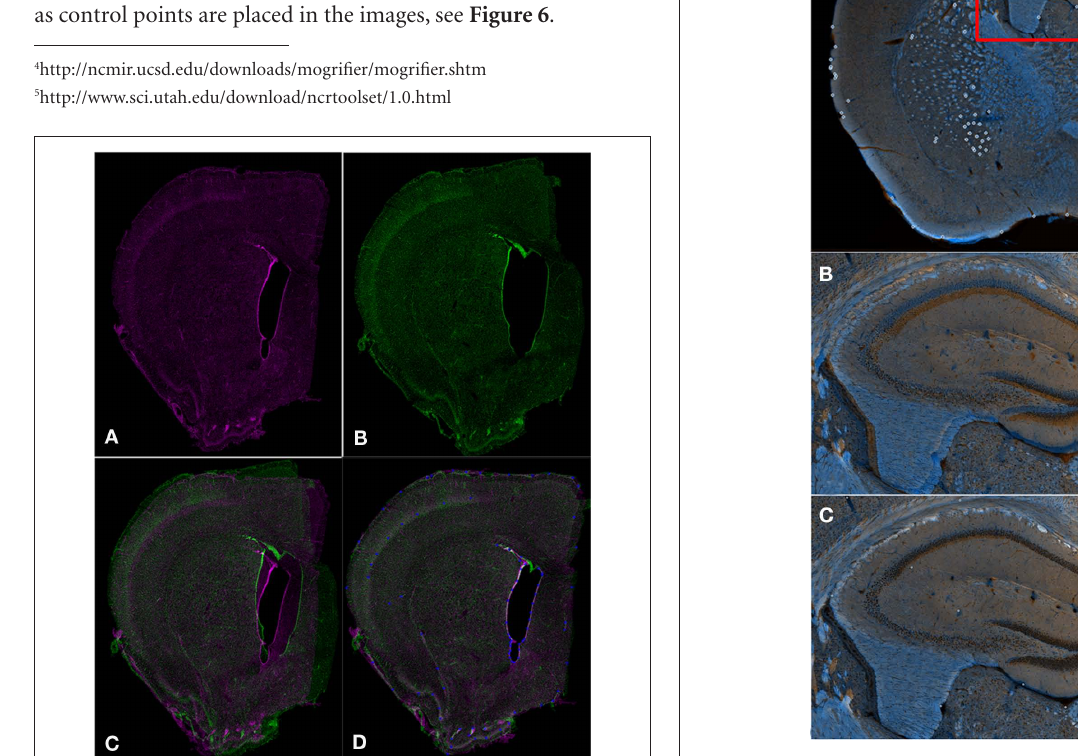
Figure 5 | Aligning serial sections using Mogrifier. Two serial coronal sections (A,B) are shown as they would appear in Mogrifier (i.e., in red and green channels). Image (B) illustrates an example of non-uniform compression of the lateral ventricle in a tissue section. Image (C) shows the overlay of slices (A,B) in the application Mogrifier before applying any transformation. Image (D) shows the overlay of slices (A,B) and the reference points (blue) after applying the thin plate spline transformation in Mogrifier.